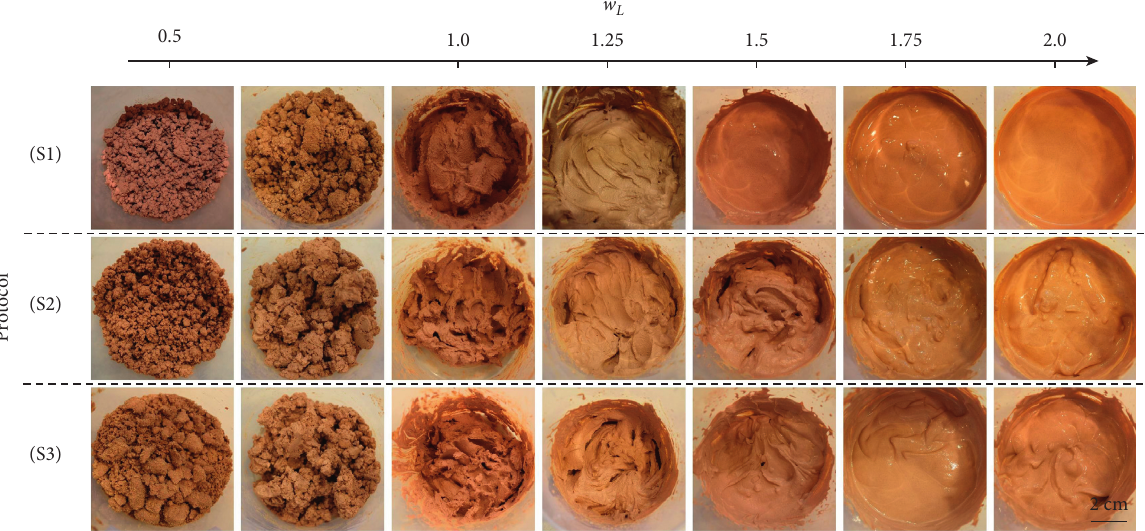
Figure 4: Optical images of the macrostructure of the sand-clay mixtures at water contents from 0.5 to 2.0 w